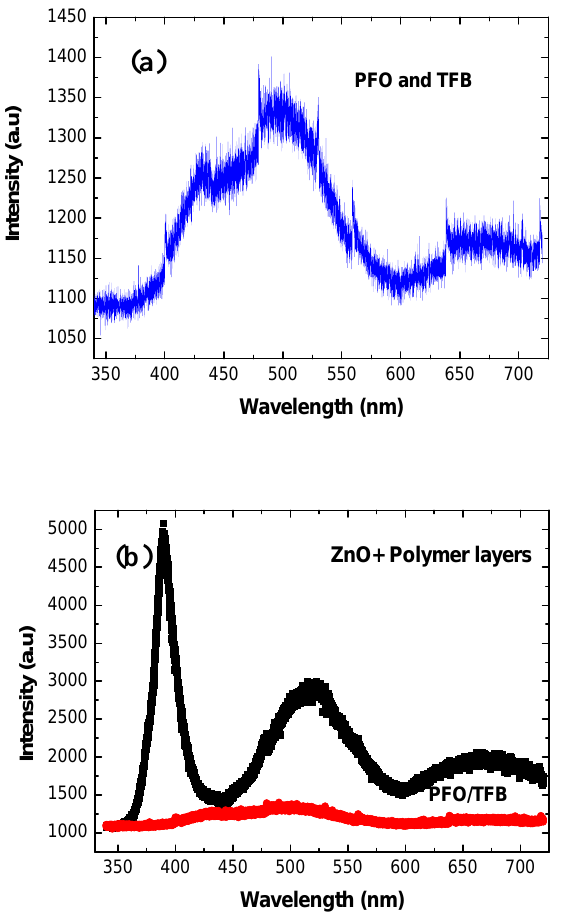
Figure 10. (a) Room temperature PL spectrum obtained from p-type polymer(s) layers spin-coated onto flexible plastic. (b) The corresponding room temperature PL spectrum after the low-temperature growth of ZnO nanorods. The lower curve represents the PL presented in part (a) of the figure to allow for a comparison of